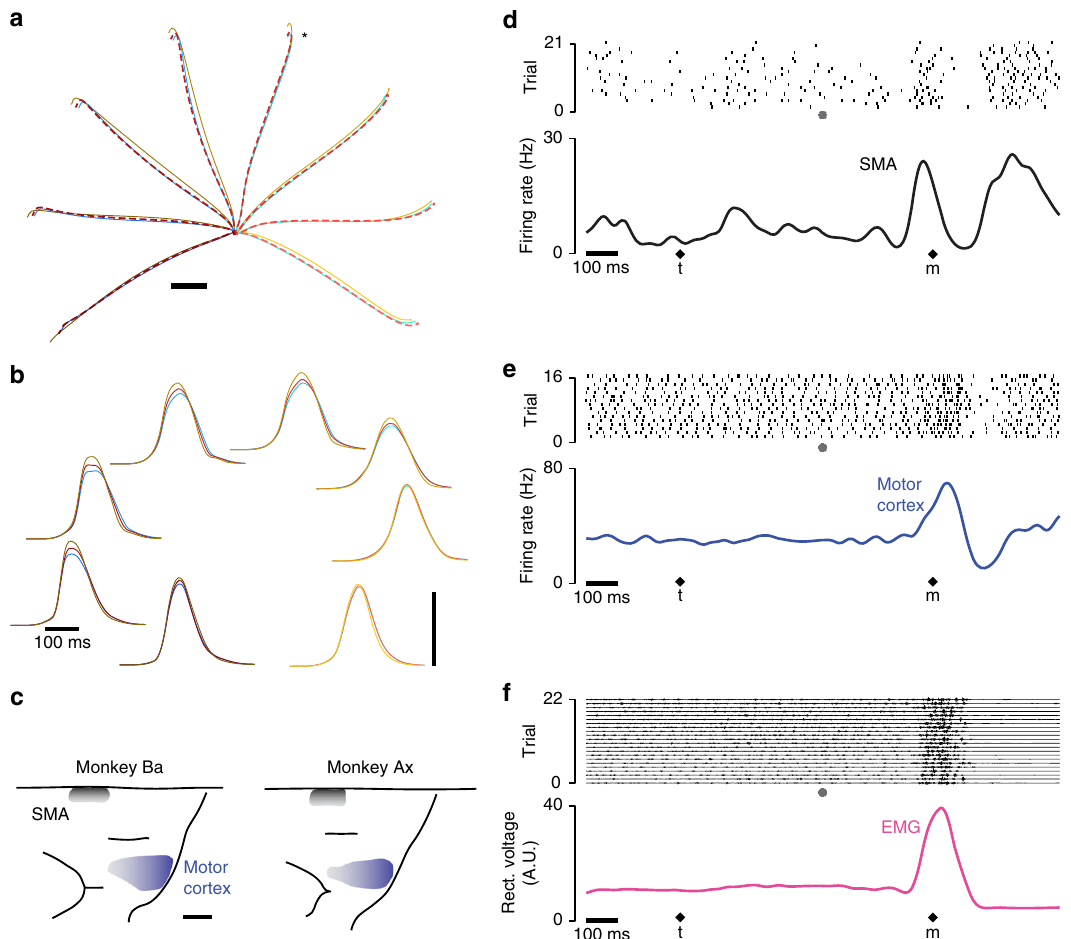
Fig. 1 Illustration of behavior and physiological recordings. a Average reach trajectories for the eight directions and three contexts. Red, blue and yellow traces show average hand position during curing cue-initiated, self-initiated, and quasi-automatic reaches. Traces are shaded from dark to light based on reach direction. Red traces are dashed to allow visualization of blue traces with which they often overlap. Data shown are for monkey Ba, and were similar for monkey Ax. Star indicates the reach direction for which neural/muscle data are shown in panel ( d ). Scale bar shows 2 cm. b Average hand-velocity pro fi les corresponding to the trajectories in panel ( a ). Scale bar shows 1 m/s. c Reconstructions of surface landmarks based on MRIs (see Supplementary Figure 1 for example MRI sections). Shaded regions indicate where penetrations entered cortex, and are shaded darker to indicate where recordings included deeper locations. Scale bar shows 5 mm. d Raster plot of spikes recorded from one SMA neuron for one reach direction during the quasi- automatic condition. Data in this and subsequent panels are for monkey Ax. Data to the left of the gray symbol are aligned to target onset (t) and data to the right are aligned to movement onset (m). Filtering and averaging of spike-trains yields a smooth fi ring rate versus time (black trace) that interpolates across the concatenation at the time indicated by the gray symbol. Filtering used a narrow (20 ms) Gaussian to ensure high-frequency aspects of the response were not lost. e Same as in d but for a neuron recorded from motor cortex. f Similar to d and e but for EMG recorded from the medial deltoid. Voltage traces show a mixture of discrete and (especially during movement) overlapping events. Discontinuities resulting from concatenation of target- locked and movement-locked data are small and barely visible. Recti fi cation, fi ltering and averaging produces a continuous trace summarizing average EMG intensity (magenta